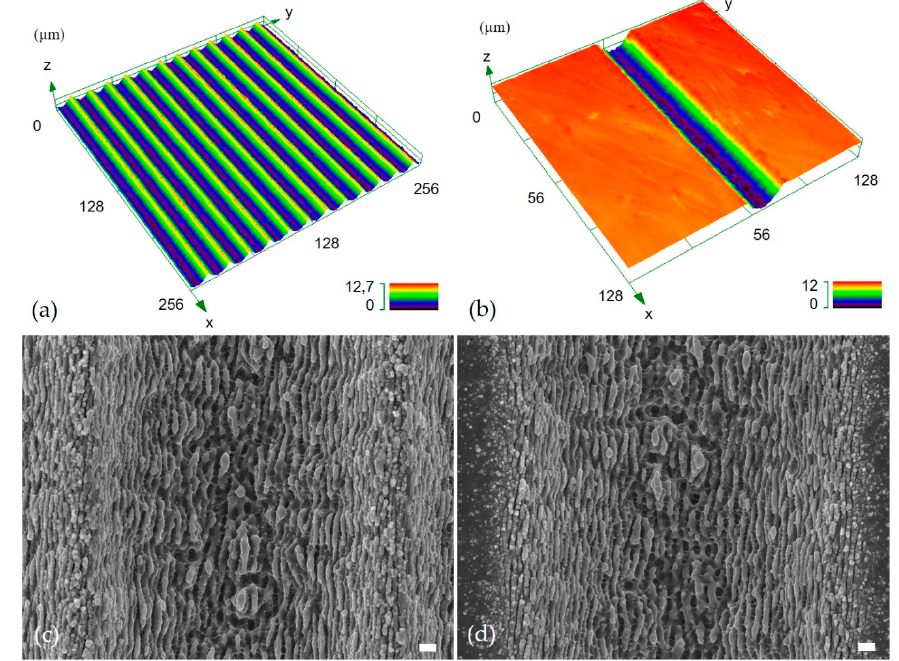
Figure 2. Surface topography after the laser process optimization. ( a ) CLSM image of deterministic structures with a strut width of 1 µm. ( b ) Detailed CLSM image of the gap profile with strut width of 300 µm. ( c ) SEM image of deterministic line structure with 1 µm (scale bar 1 µm); the struts featuring FLIPPS on the top surface are arranged to the left and right sides of the picture. ( d ) SEM image of deterministic line structure with a 300-µm strut width; sections of the strut surfaces can be seen to the left and right image border. FLIPPS can be observed on the entire surface of the grooves.